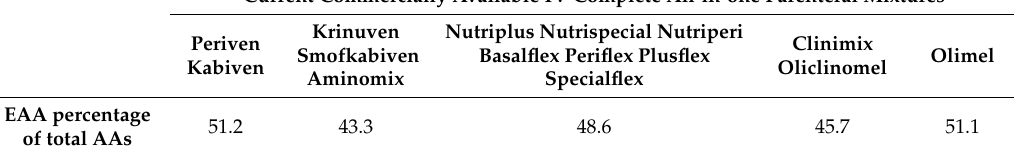
Table 2. EAA percentage of total AAs in several IV complete, all-in-one parenteral mixtures that are commercially available in